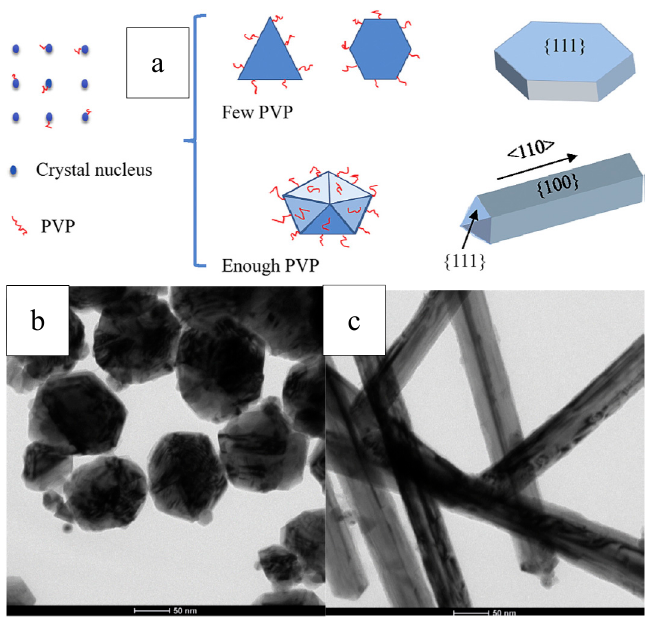
Figure 11. Schematic drawing of the formation ( a ) and SEM images ( b , c ). Reproduced with permission [169]. Copyright 2018, Elsevier.